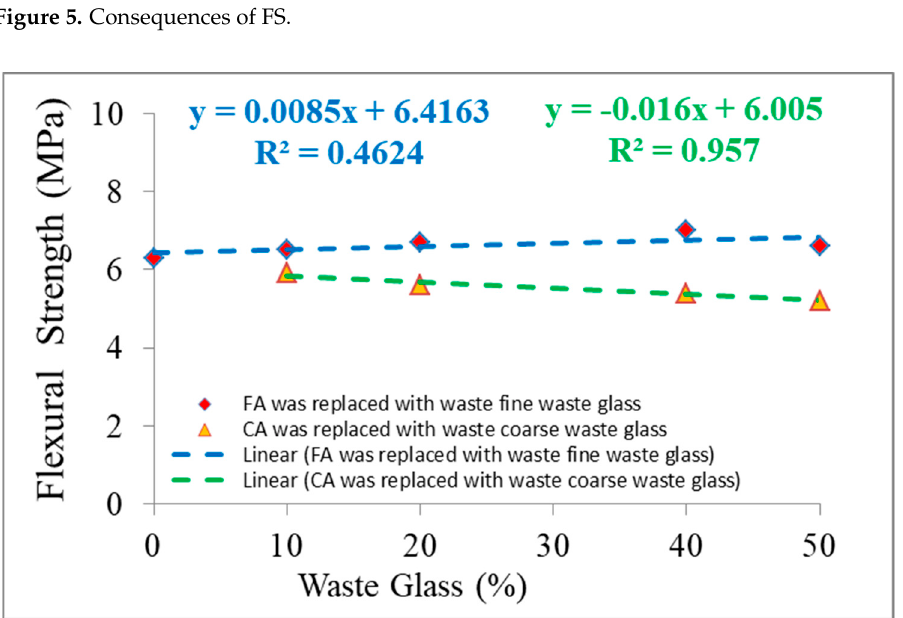
Figure 6. Consequences of tensile FS tests of concrete examples with changed CWG substances.